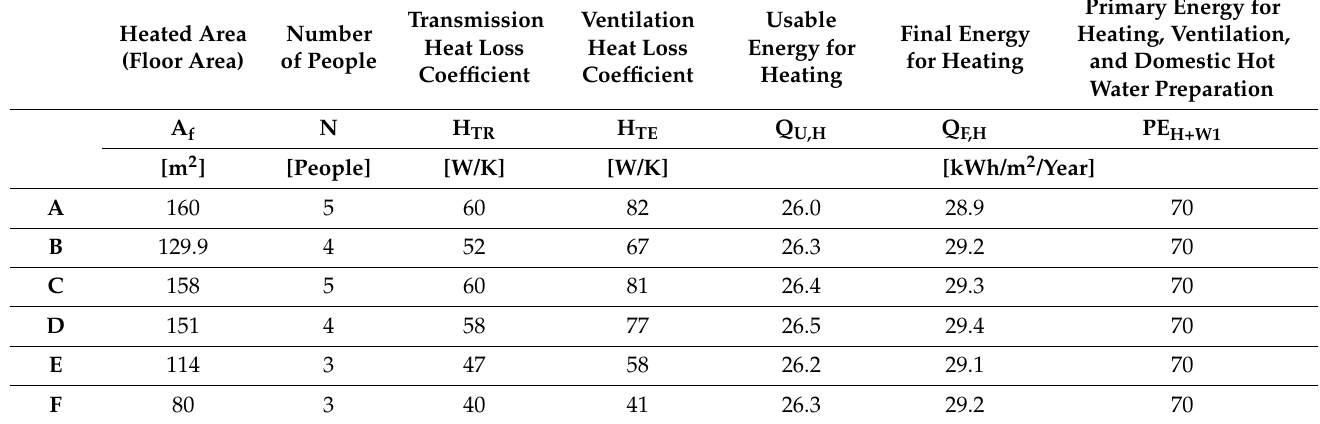
Table 8. Primary energy indices for six buildings determined with heat losses meeting Polish requirements (DHW consumption = 1.4 dm 3 /m 2